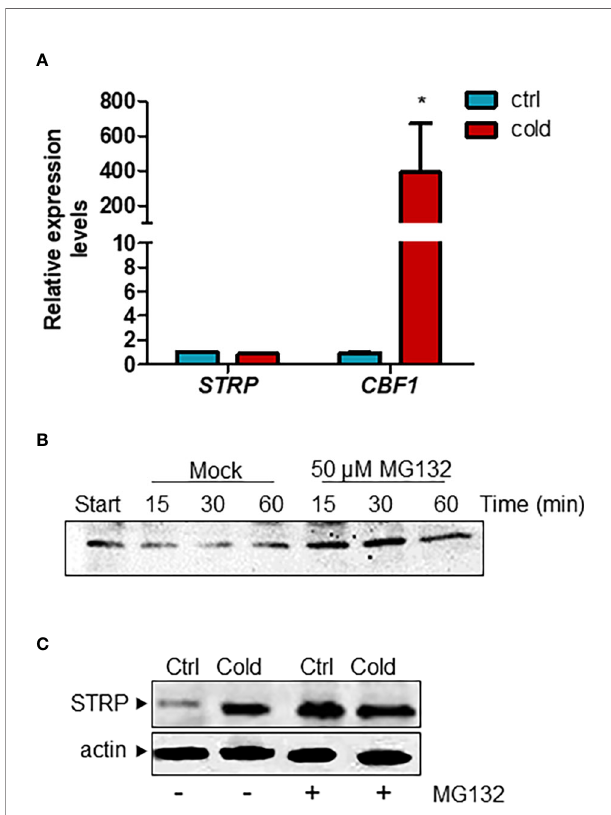
FIGURE 2 | Cold stress stabilizes STRP protein by inhibiting its proteasome- mediated degradation. (A) STRP expression levels under cold stress was determined on total RNA extracted from A. thaliana plants exposed 6 h at 4°C. RNA was retrotranscribed and analysed by RT-qPCR. mRNA levels were normalized to GAPDH mRNA. Error bars are S.E.M. of three independent experiments. *P < 0.01, by Student ’ s t-test. (B) cell-free degradation assay: 15 µg of total extract were treated with 50 µM MG132 or DMSO for 15, 30 and 60 min and then analysed by western blotting with anti- STRP antibodies. (C) effect of MG132 on STRP levels. 20 µg of cytosol extracted from control (Ctrl) and cold-exposed (Cold) plants treated with MG132 for 18 h were separated by SDS-PAGE, transferred on PVDF membrane and immunodecorated with anti-STRP antibodies. Actin was used as loading